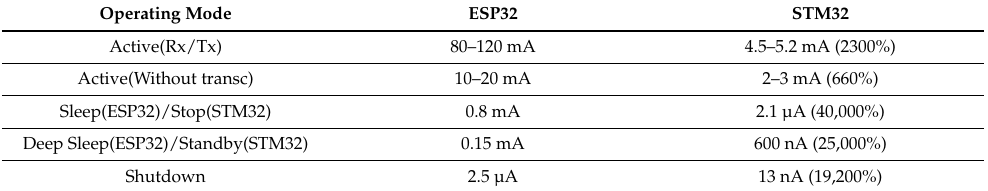
Figure 7. Prototypes based on ESP32 and STM32 microcontrollers. ( a ) Power and microcontroller. A. Temperature Sensor; B. Buzzer; C. LoRa transceiver; D. Main Board. ( b ) Peripherals assembled. ( c ) Devices used for system analysis. ( d ) New node based on STM32 microcontroller. Table 5. Comparison of power consumption between the proposed